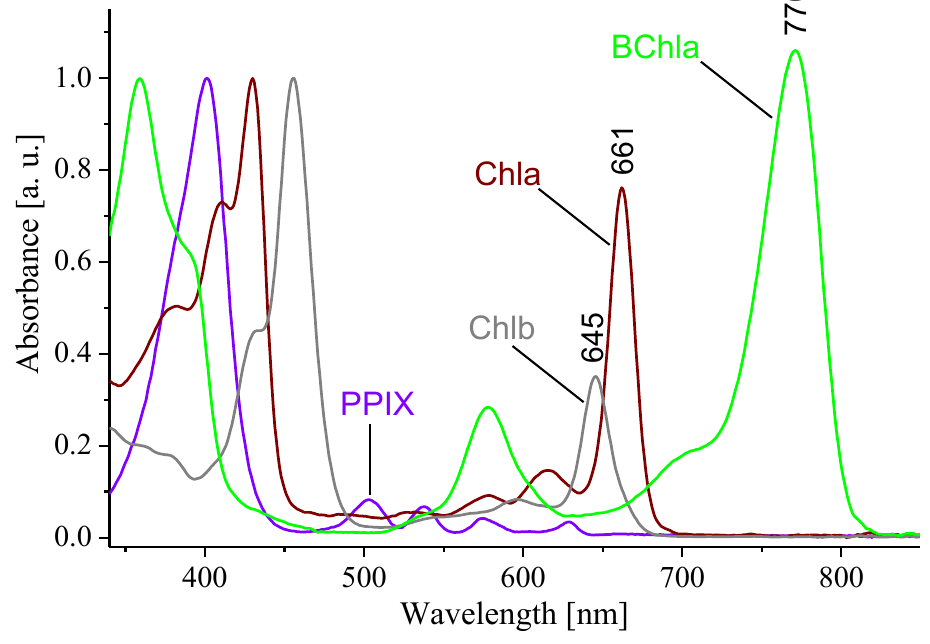
Figure 2. Electronic absorption spectra of PPIX, Chla, Chlb, and BChla recorded at ambient temperature in acetone. The spectra were normalized to the maxima of the Soret